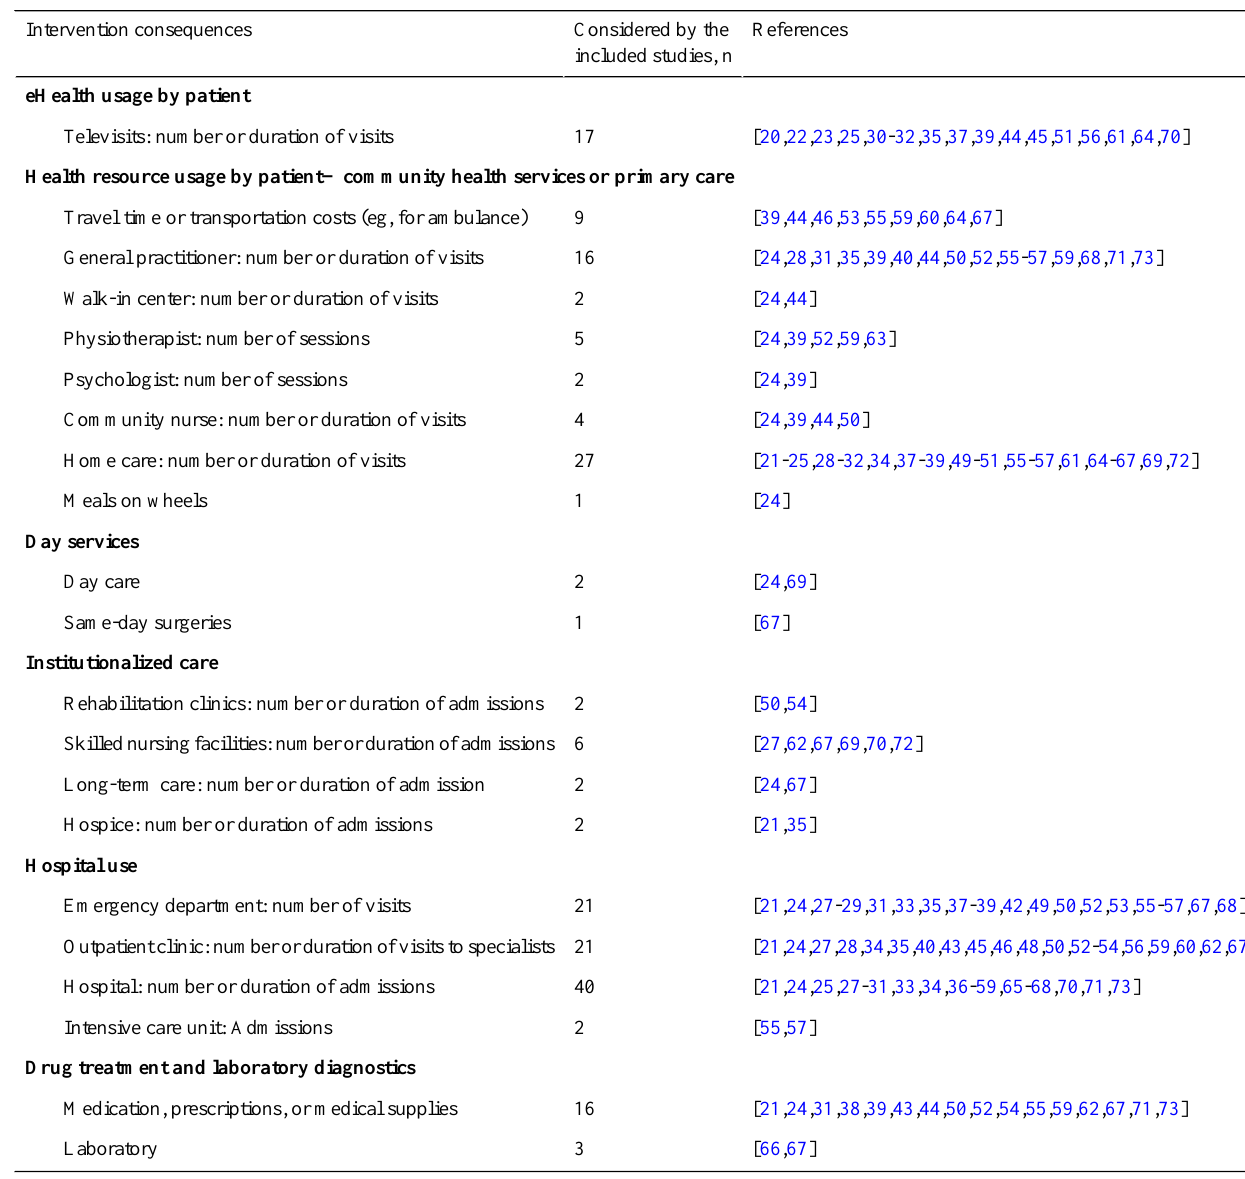
ReferencesConsidered by the included studies,